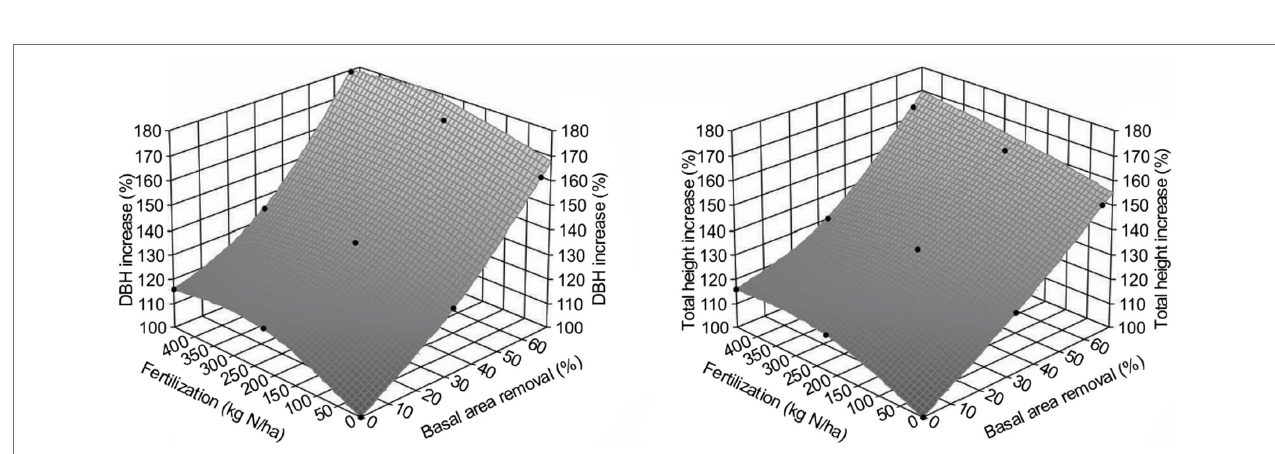
FIGURE 6 | Effect of different treatments combinations on the percentage of small (left, represented by 1 inches × 3 inches lumber) and large (right, represented by 2 inches × 8 inches lumber) dimension lumbers of Douglas-fir ( Pseudotsuga menziesii Mirbel) trees, 40 years after application at the Shawnigan Lake trial in British Columbia, Canada.